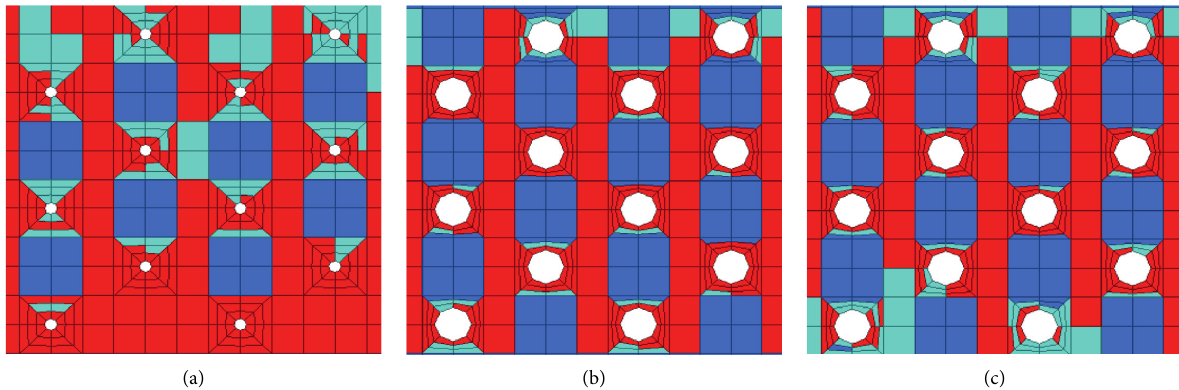
Figure 10: Distribution law of plastic zone of nonequal diameter precise pressure relief hole. (a) 4m from the coal rib. (b) 6 m from the coal rib. (c) 8m from the coal